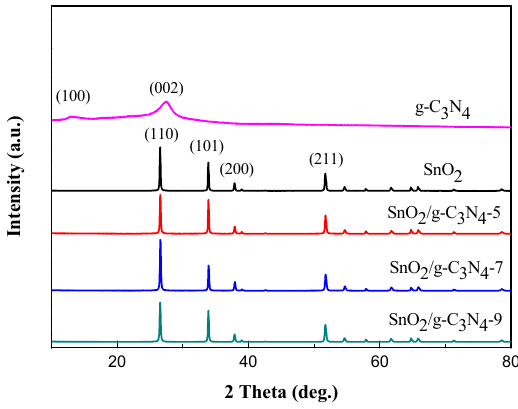
Figure 1. X-ray powder diffraction ( XRD) patterns of the synthesized SnO 2 , g-C 3 N 4 , and g-C 3 N 4 nanosheets-decorated tin oxide flower-like nanorods composites (SnO 2 /g-C 3 N 4 -5, SnO 2 /g-C 3 N 4 -7, and SnO 2 /g-C 3 N 4 -9).